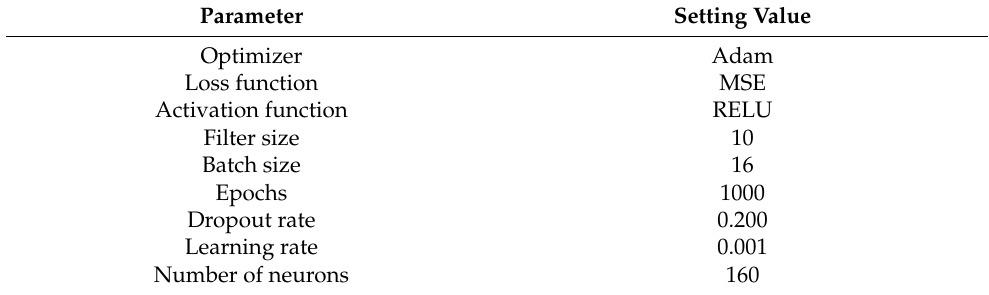
Table 3. Parameter